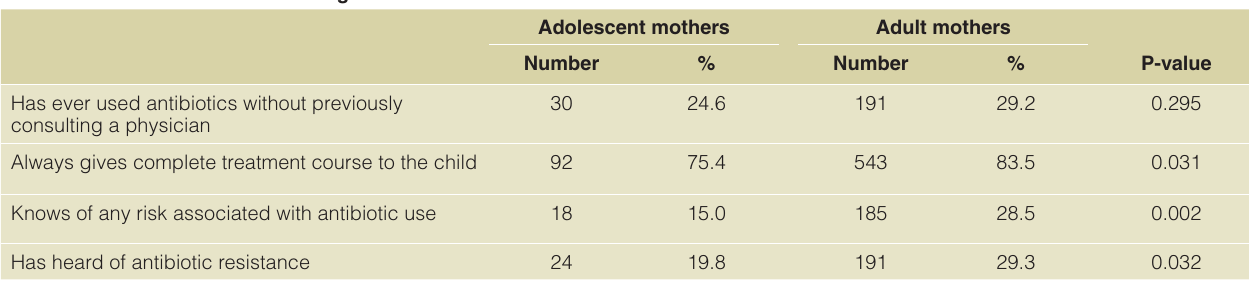
Table 3. Antibiotic use and knowledge of the